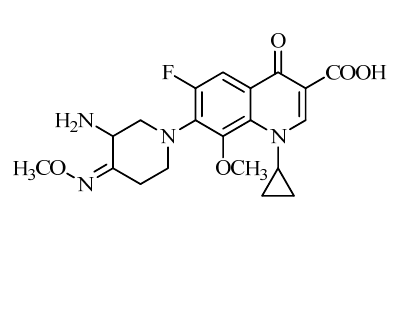
Figure 1. Structure of